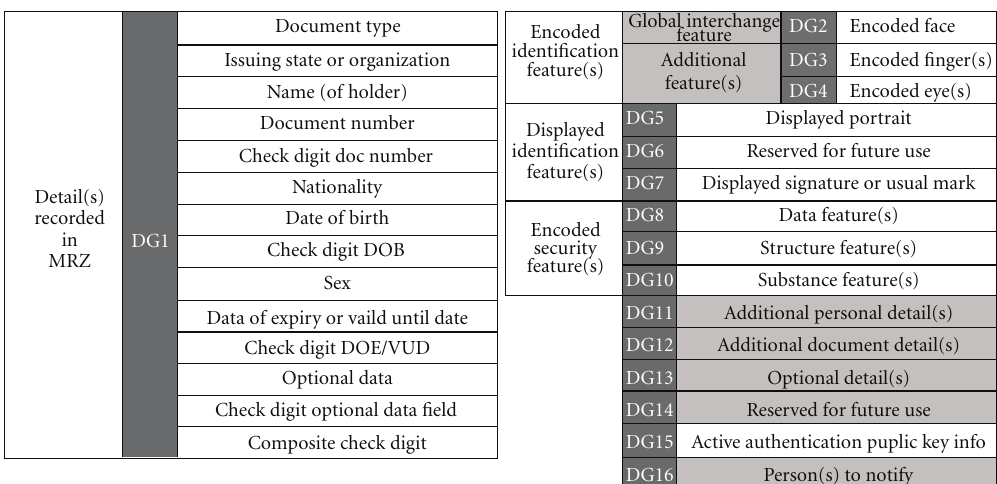
Figure 2: Memory data groups of passport RFID chip. Please notice especially the description of DG1–DG5 (source: [3]).